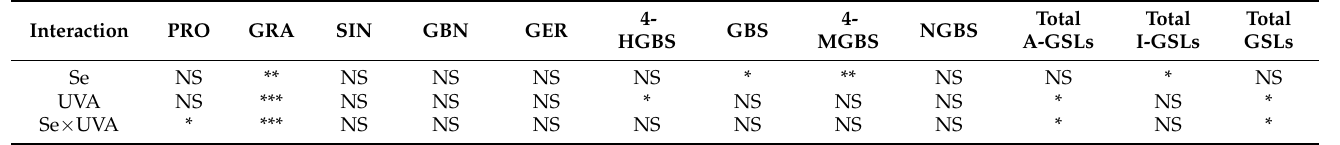
Table 5. The interaction effects of Se and UVA on GSLs contents of broccoli microgreens.